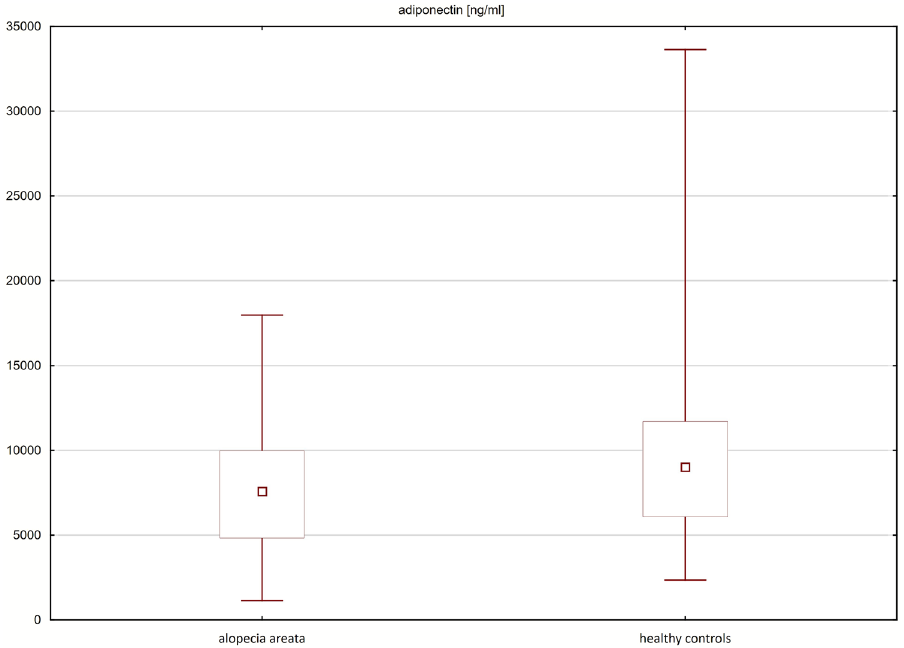
Figure 1. Serum concentrations of adiponectin in patients with alopecia areata and healthy controls.